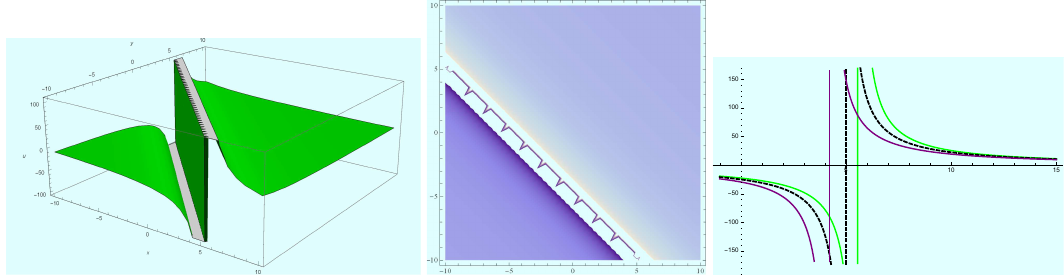
Figure 8. Evolution of traveling wave of singular soliton solution (25) at t = − 6 and z = 25.